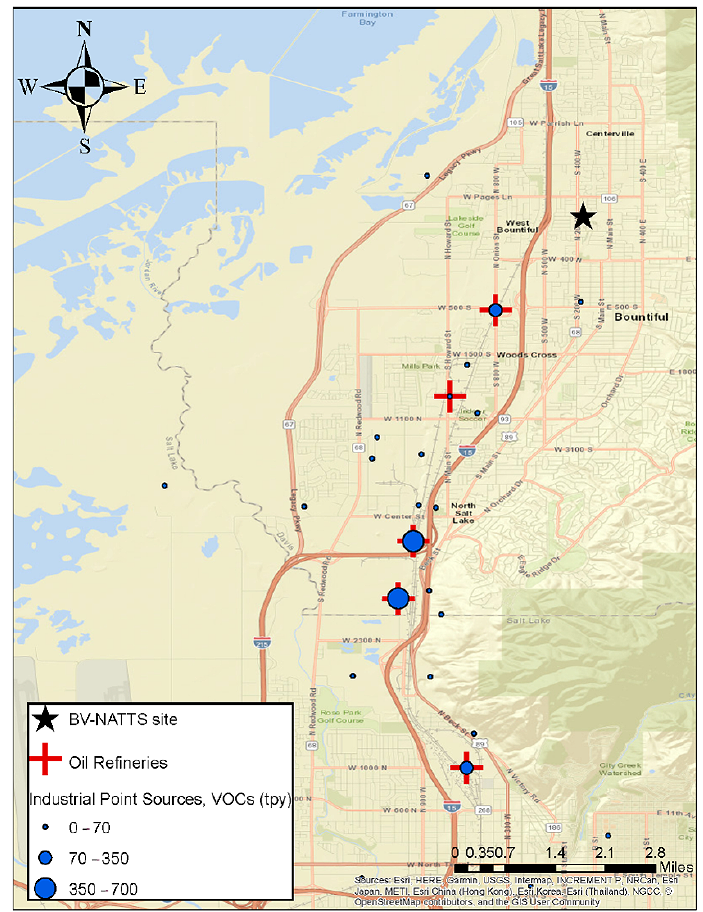
Figure 1. The locations of various VOC emission sources, oil refineries (red crosses) and industrial (blue circles) with emission strengths (tons year − 1 ) located to the SSW of the Bountiful NATTS sampling site (black star). Green color represents mountains with forested areas. Emission strengths are taken from permits issued by the State of Utah Department of Air Quality. Additionally, included is the location of major roadways and forested areas in the area.